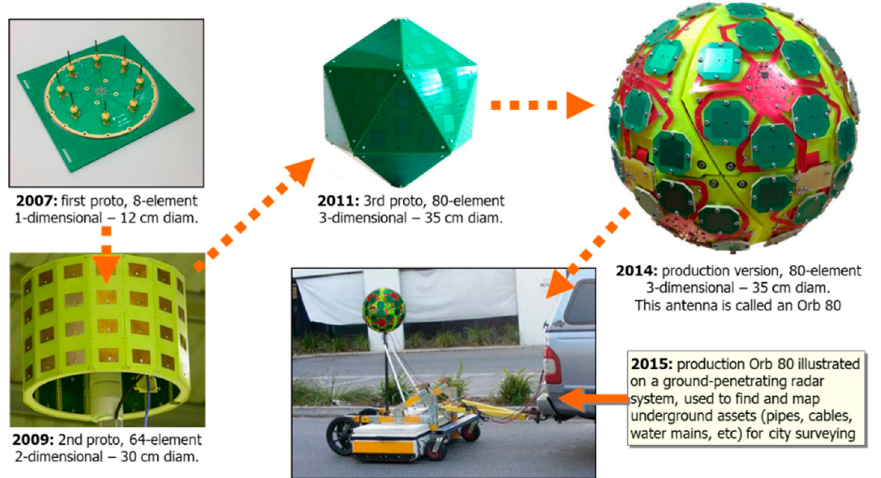
Figure 3. The prototypes and current production model of the Locata beam-forming VRay antenna.